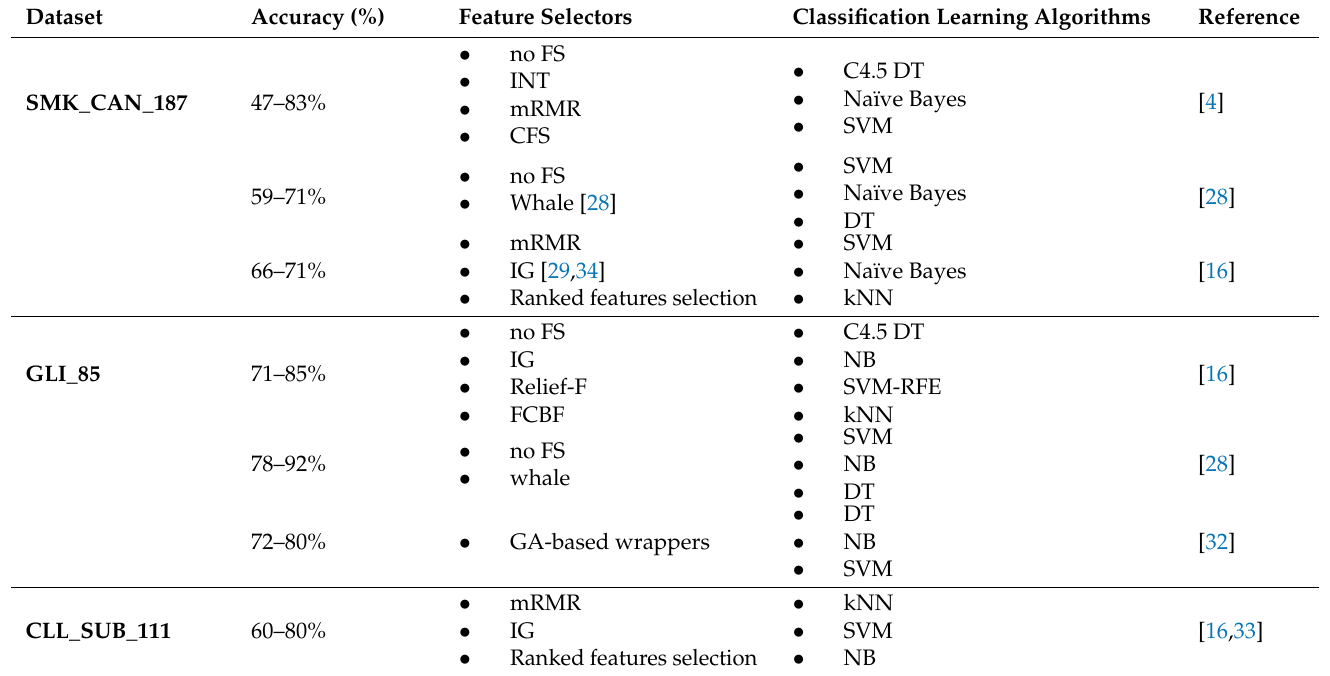
Table 2. Summary of classification accuracies attained by different combinations of feature selectors and classification learning algorithms as reported by selected